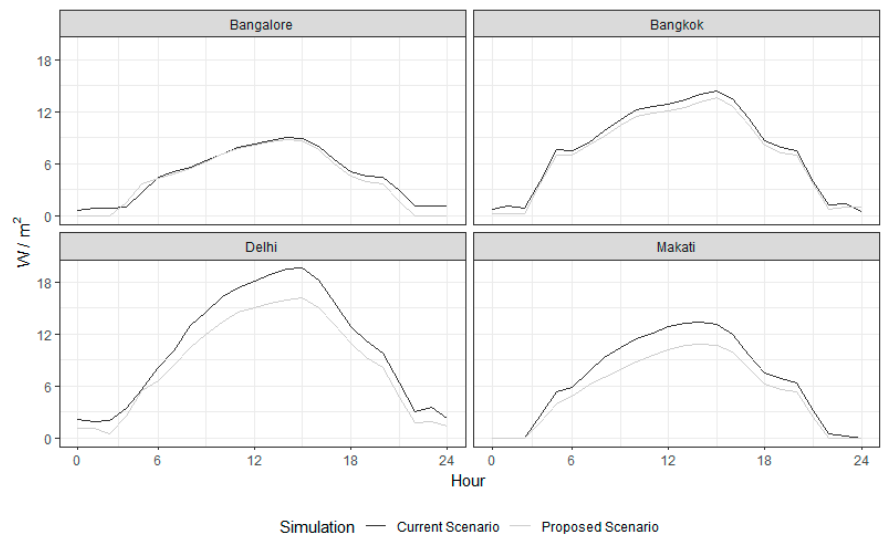
Figure 5. Average hourly cooling energy loads for the both the current (dark) and proposed (light) setpoint scenarios. Both scenarios are plotted for cooling loads in the hottest week in an average year (weekdays only). Peak reductions of 2.7% and 19.7% are observed at 14:00 p.m. for Bangalore and Makati, whereas reductions of 5.8% and 17.8% are observed at 15:00 p.m. for Bangkok and Delhi.